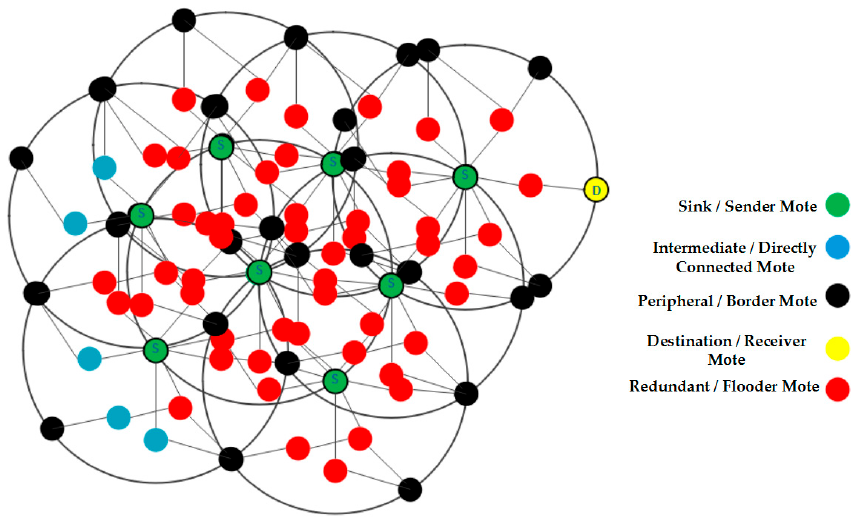
Figure 2. Flooding as a result of redundant queries.